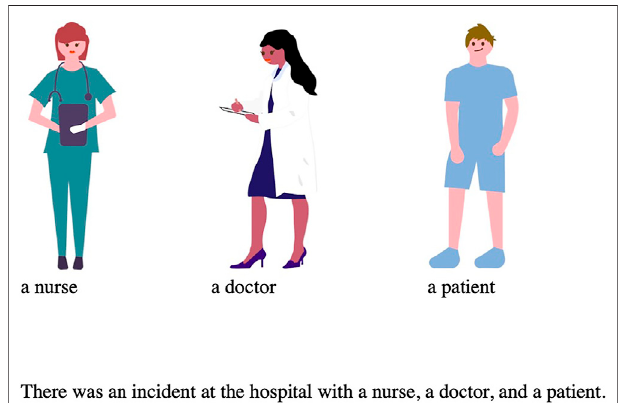
FIGURE 3 | Sample item from Experiment 3 in the NP1&NP2 full stop condition.